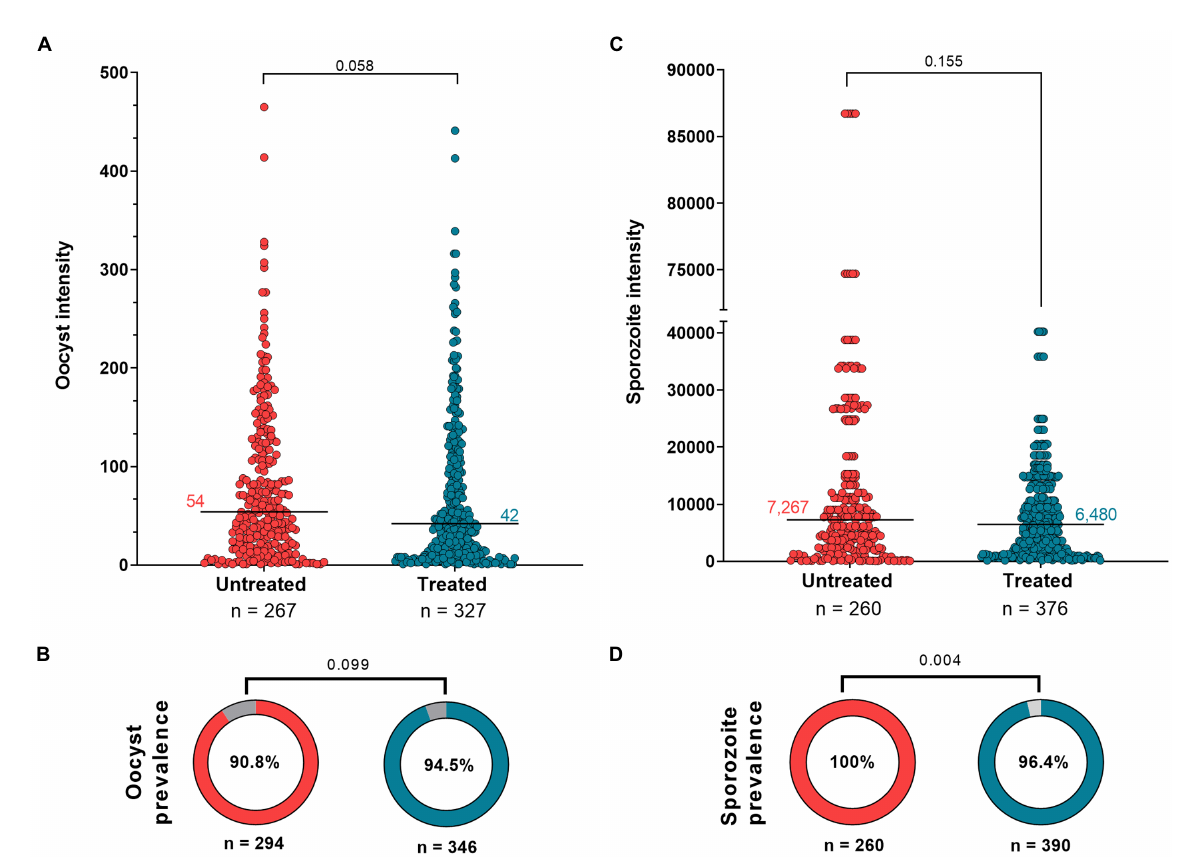
FIGURE 3 Antibiotic effect on Anopheles darlingi infected by Plasmodium vivax . (A) Oocyst intensity in untreated and treated mosquitoes; and (C) Sporozoite intensity in untreated and treated groups. The Mann Whitney test was used to compare groups. Each circle indicates a mosquito with at least 1 parasite. (B,D) show prevalence data of oocyst and sporozoite stages, respectively. The χ 2 test was used to compare groups. The intensity and prevalence parameters were tested in nine independent DMFAs, which showed prevalence above 40% in the control group [the independent DMFA “5,033” was removed from analysis (Supplementary Table S1)]. Value of p less than 0.05 is considered statistically significant.